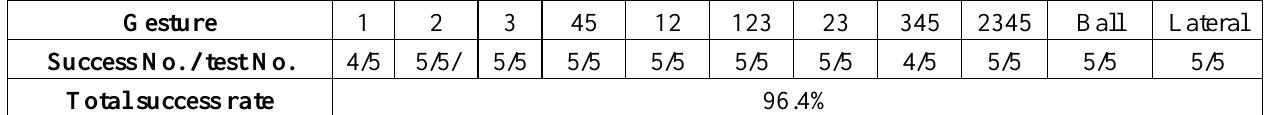
Table 4. Success rate of the 11-gesture classification of the third subject. Gesture